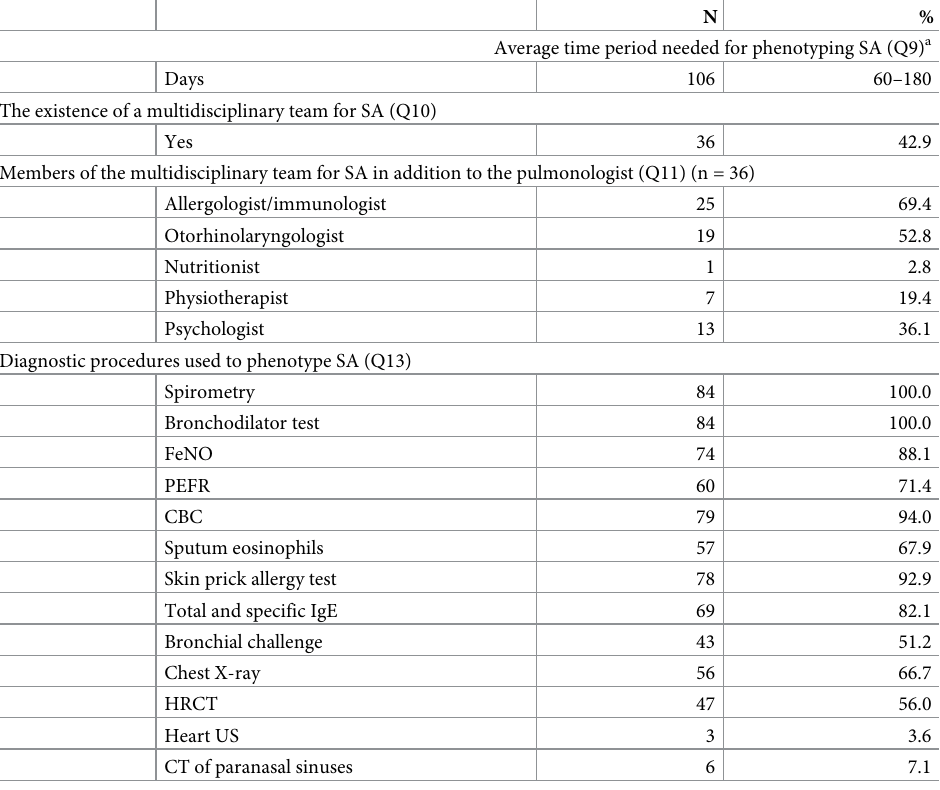
Table 3. Beliefs and attitudes about diagnosing severe asthma (SA) (N = 84). N % Average time period needed for phenotyping SA (Q9) a Days 106 60–180 The existence of a multidisciplinary team for SA (Q10) Yes 36 42.9 Members of the multidisciplinary team for SA in addition to the pulmonologist (Q11) (n = 36) Allergologist/immunologist 69.4 Otorhinolaryngologist